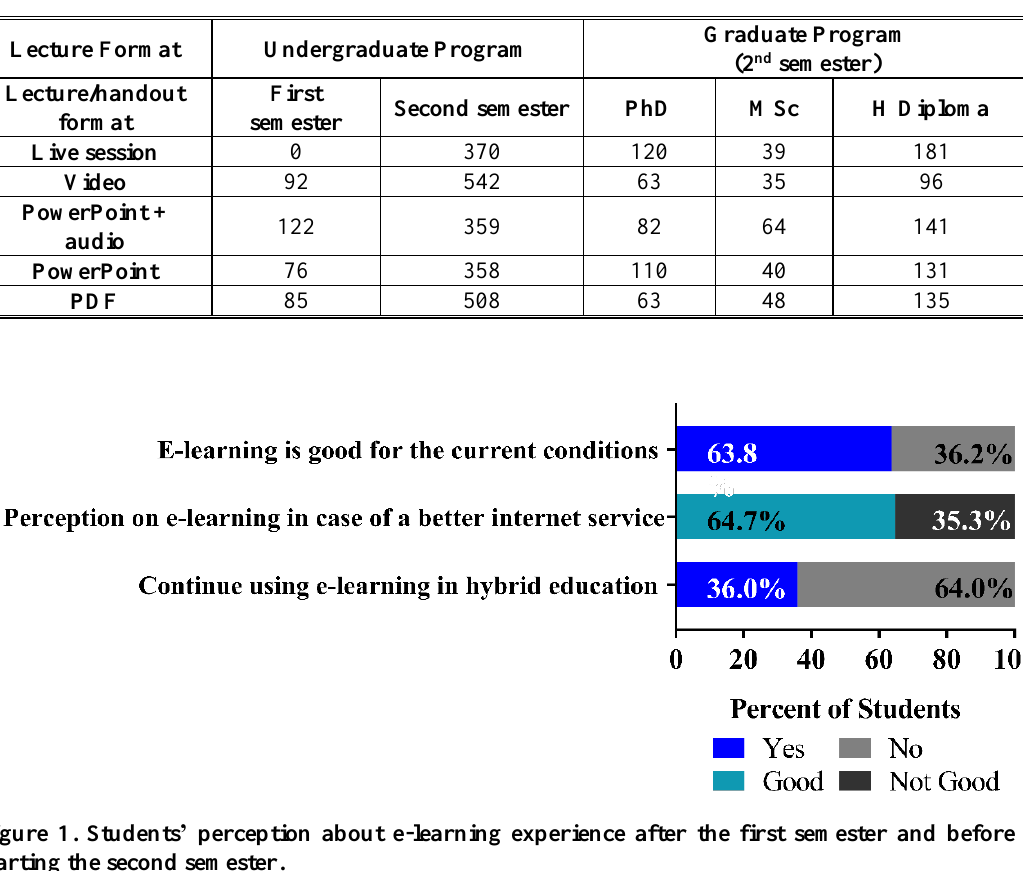
Table 1.Lecture format used in the graduate and undergraduate programs.